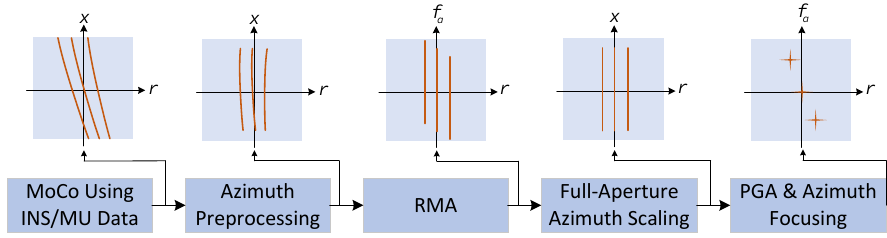
Figure 4. Flow chart of motion compensation.